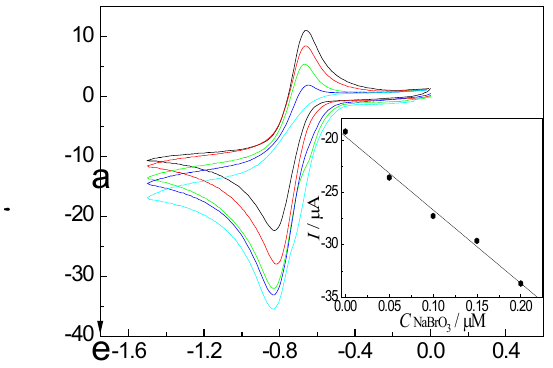
Figure 4. CVs of Zn-CPE in 0.1 M, pH 6.1, B-R buffer solution containing (a–e) 0, 0.05, 0.10, 0.15 and 0.20 μM bromate with the scan rate as 0.15 V s -1 . Inset: the cathodic peak current versus bromate